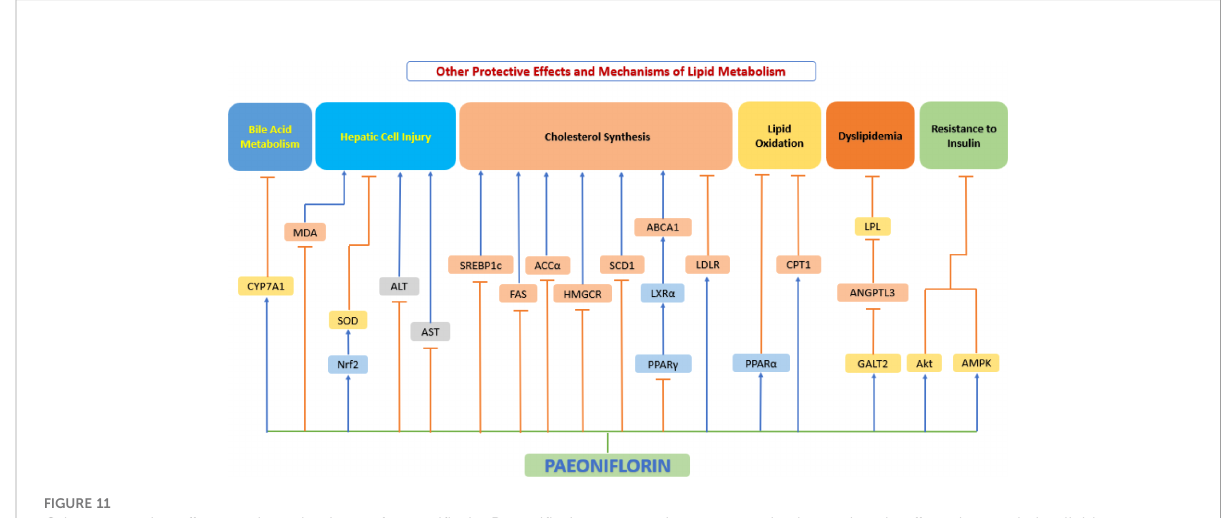
FIGURE 11 Other protective effects and mechanisms of paeoni fl orin. Paeoni fl orin can exert important anti-atherosclerotic effects by regulating lipid metabolism. ABCA1, ATP binding cassette transporter A1; ACC a , acetyl-CoA carboxylase- a ; Akt, serine-threonine kinase; ALT, alanine aminotransferase; AMPK, AMP-activated protein kinase; ANGPTL3, Angiopoietin-like 3; AST, aspartate aminotransferase; CPT1, carnitine palmitoyltransferase 1; CYP7A1, cytochrome P450 7A1; FAS, fatty acid synthase; GALT2, Hydroxyproline-O-galactosyltransferase; HMGCR, anti- hydroxy-3-methylglutaryl-CoA reductase; LDLR, low-density lipoprotein receptor; LPL, lipoprotein lipase; LXR a , liver X receptor a ; MDA, malondialdehyde; Nrf2, nuclear factor E2-related factor 2; PPAR − a , peroxisome proliferator − activated receptor a ; PPAR − g , peroxisome proliferator − activated receptor g ; SCD1, stearoyl-CoA desaturase 1; SOD, superoxide dismutase; SREBP1c, sterol regulatory element-binding protein